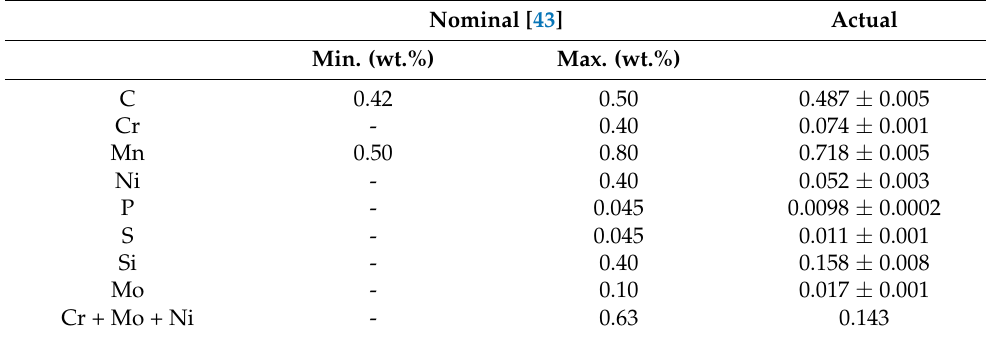
Table 1. Nominal [43] and actual chemical composition (wt. %) of C45 carbon steel used in this